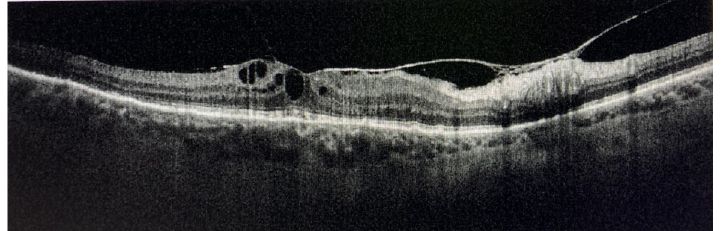
Figure 19. OCT: typical thick vitreoretinal traction in the macular area. CME is also evident. Radosavljevic et al. noticed that 20.7% of their patients suffered from glaucoma and Reid showed that 36% of sarcoid uveitis patients suffered from high IOP [49,245].